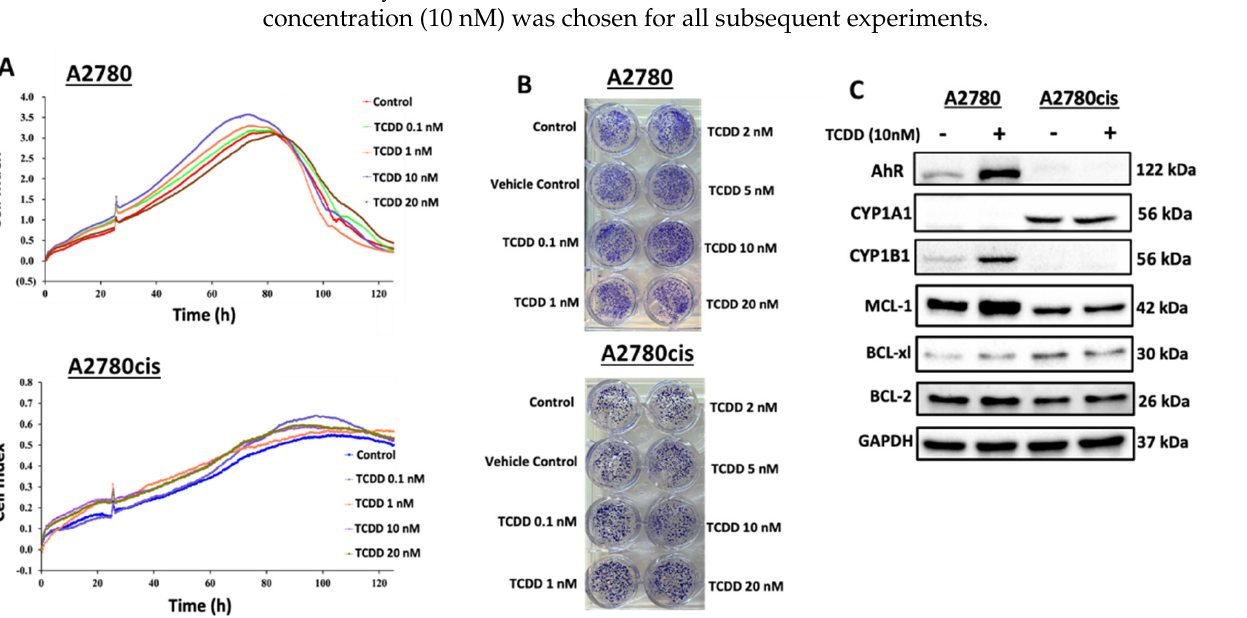
Figure 2. Effect of AhR activation on cell growth, cell survival, and AhR and BCL-2 family proteins in A2780 and A2780cis cell lines. A2780 and A2780cis cells were treated with wide concentrations of TCDD at different time intervals. ( A ) Cell growth was real-time monitored for 120 h. ( B ) Cell survival was determined by colony formation assay analysis. Protein expression levels of ( C ) AhR, CYP1A1, CYP1B1, MCL − 1, BCL − 2, and BCL − xl proteins in response to 24 h TCDD treatment were determined by Western blot analysis. The protein panels are a composite of different blots and are representative blots for the indicated proteins and the loading control.